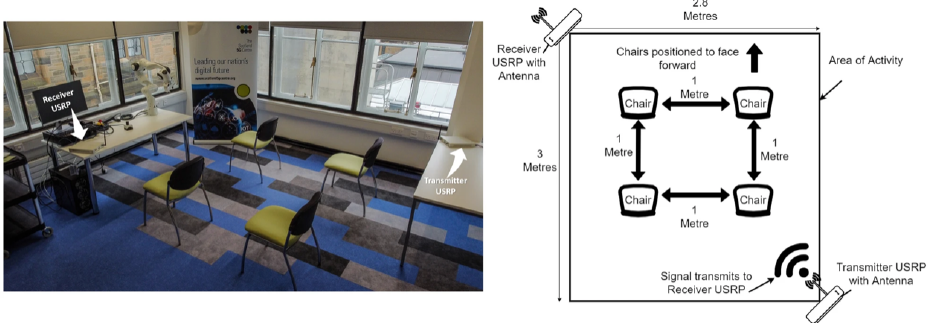
Figure 2. Setup for recording distinct activities utilising the 5G frequency in an experimental setting